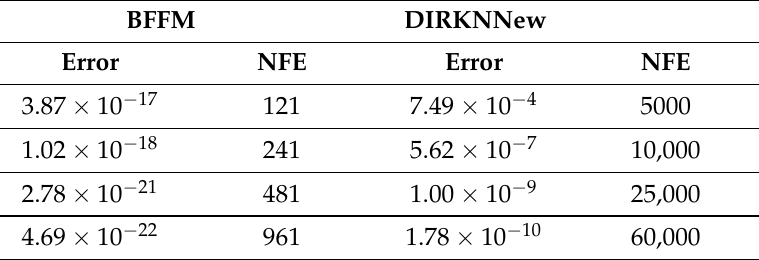
Table 6. Data for Example 6 on the interval [ 0,10 ]